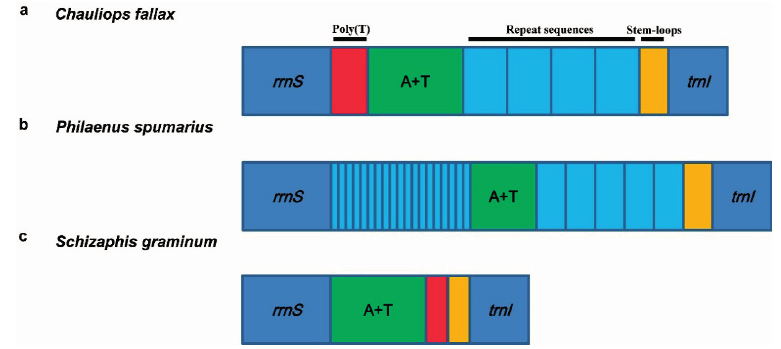
Figure 5. Control regions of mitogenomes from some representative species of Hemiptera. ( a ) the control region of Chauliops fallax includes four parts; ( b ) the control region of